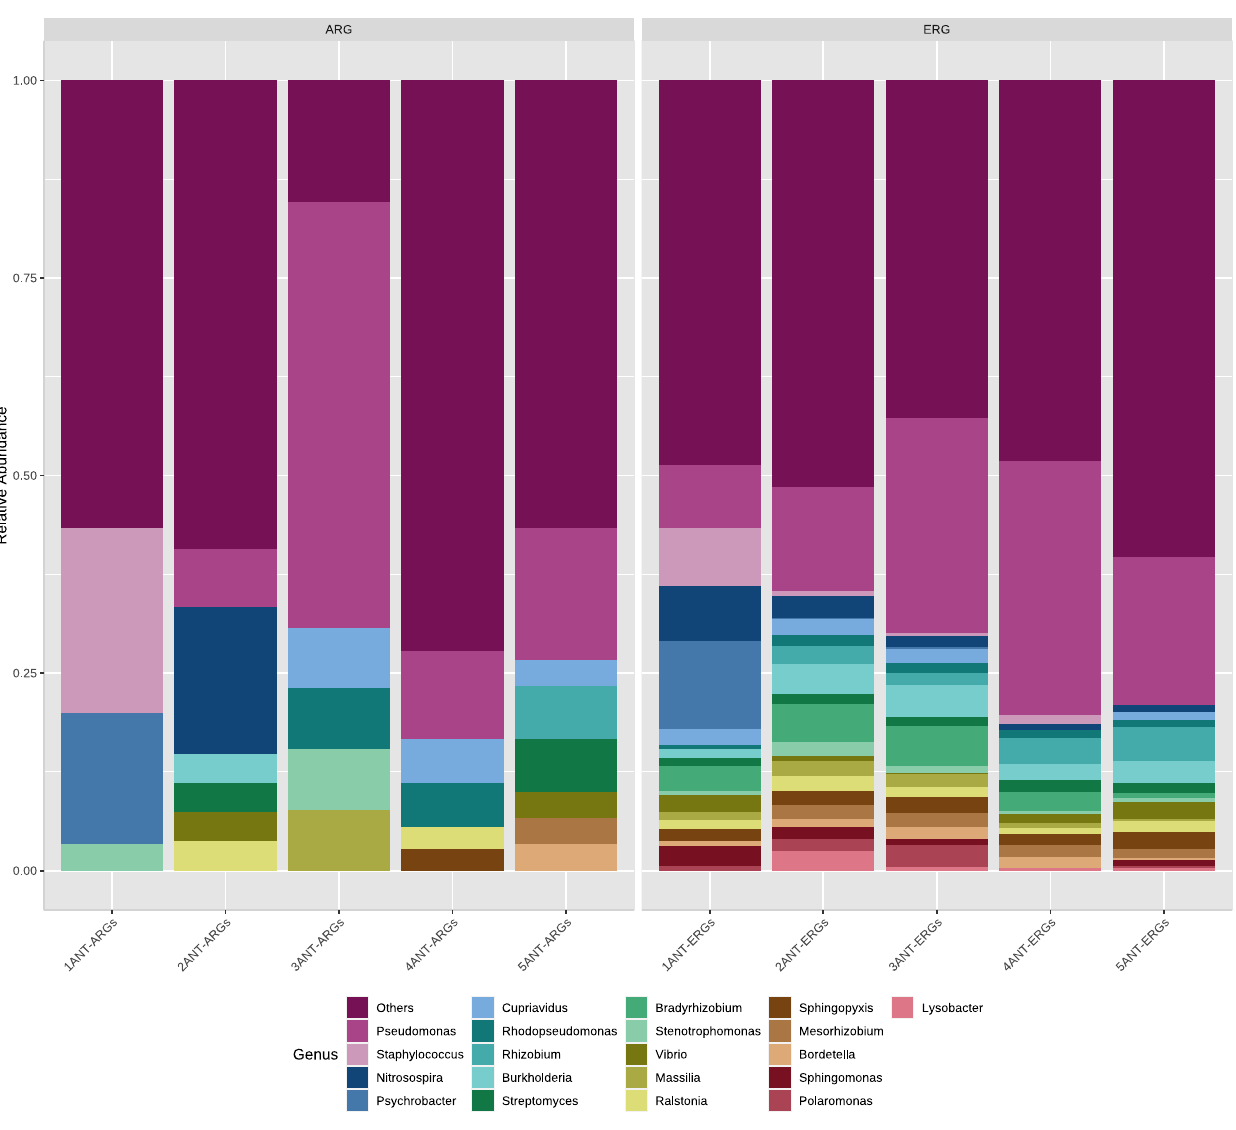
Figure 4. Relative abundance at and genus taxonomic levels for ARGs and ERGs in Deception Is- land.